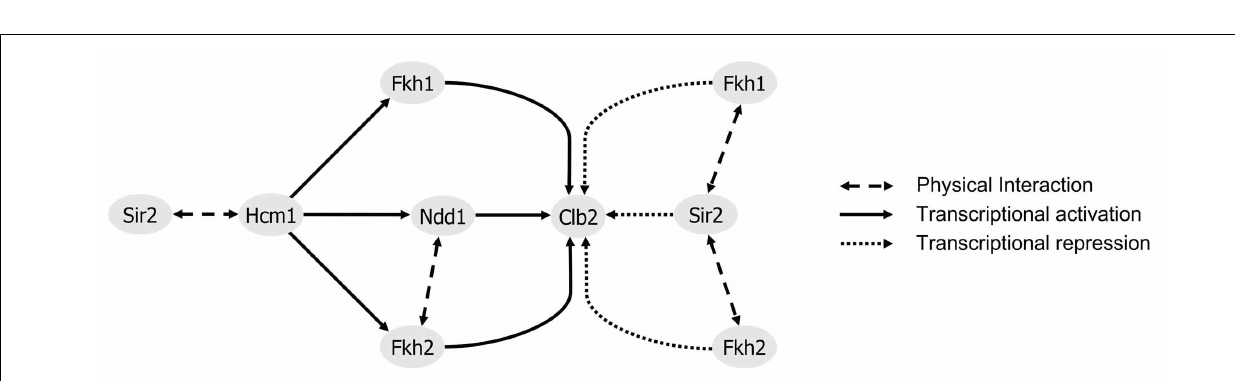
FIGURE 8 | Regulatory model of Clb2 expression. The transcription factor Hcm1 is required for periodic expression of the G2/M phase-specific regulators Fkh1, Fkh2, and Ndd1 (Pramila et al., 2006). Control of Clb2 expression requires the binding of Fkh1, Fkh2, and the transcriptional coactivator Ndd1 (Darieva et al., 2003; Reynolds et al., 2003; Pic-Taylor et al., 2004). In late M phase and during G1 phase,